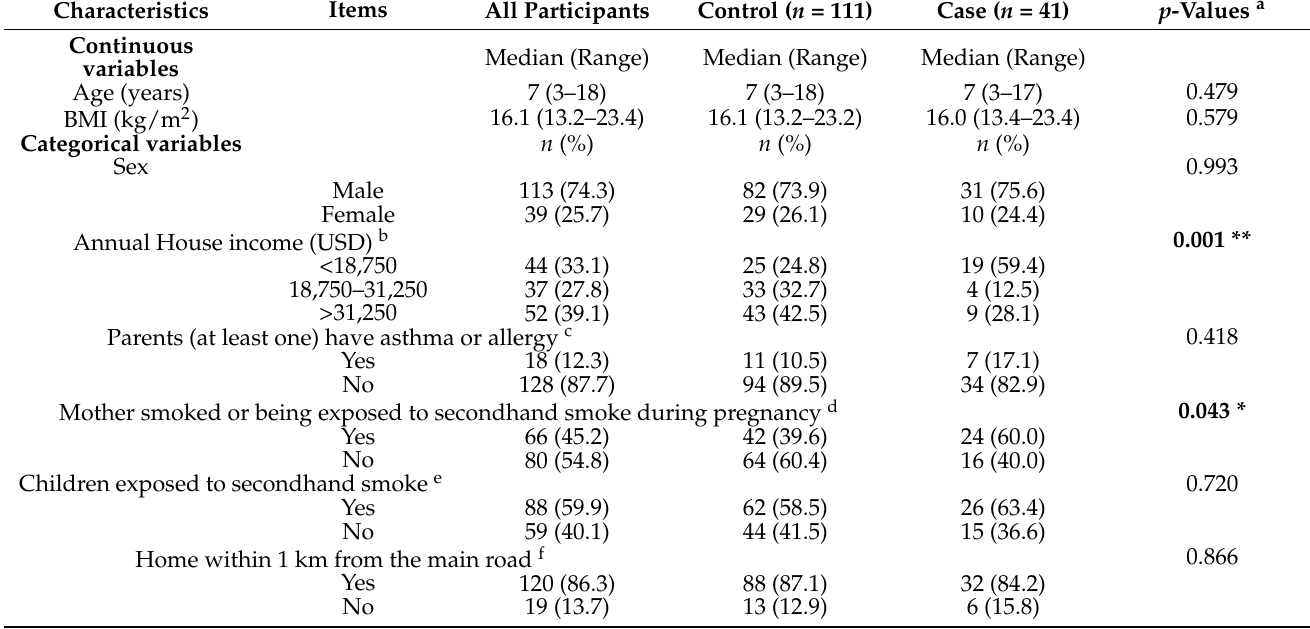
Table 1. Characteristics of subjects in control ( n = 111) and case ( n = 41)